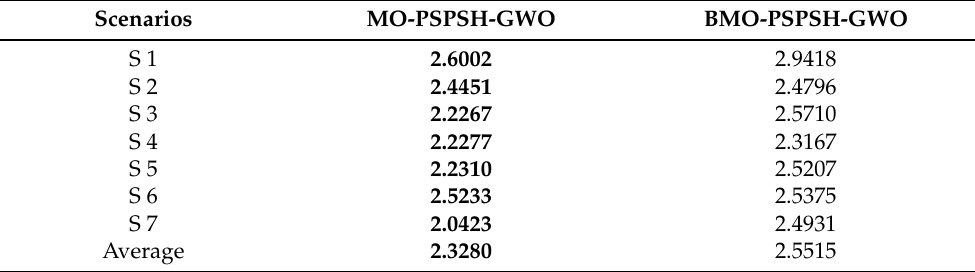
Table 7. Comparison between MO-PSPSH-GWO, BMO-PSPSH-GWO in terms of peak-to-average ratio (PAR) reduction.